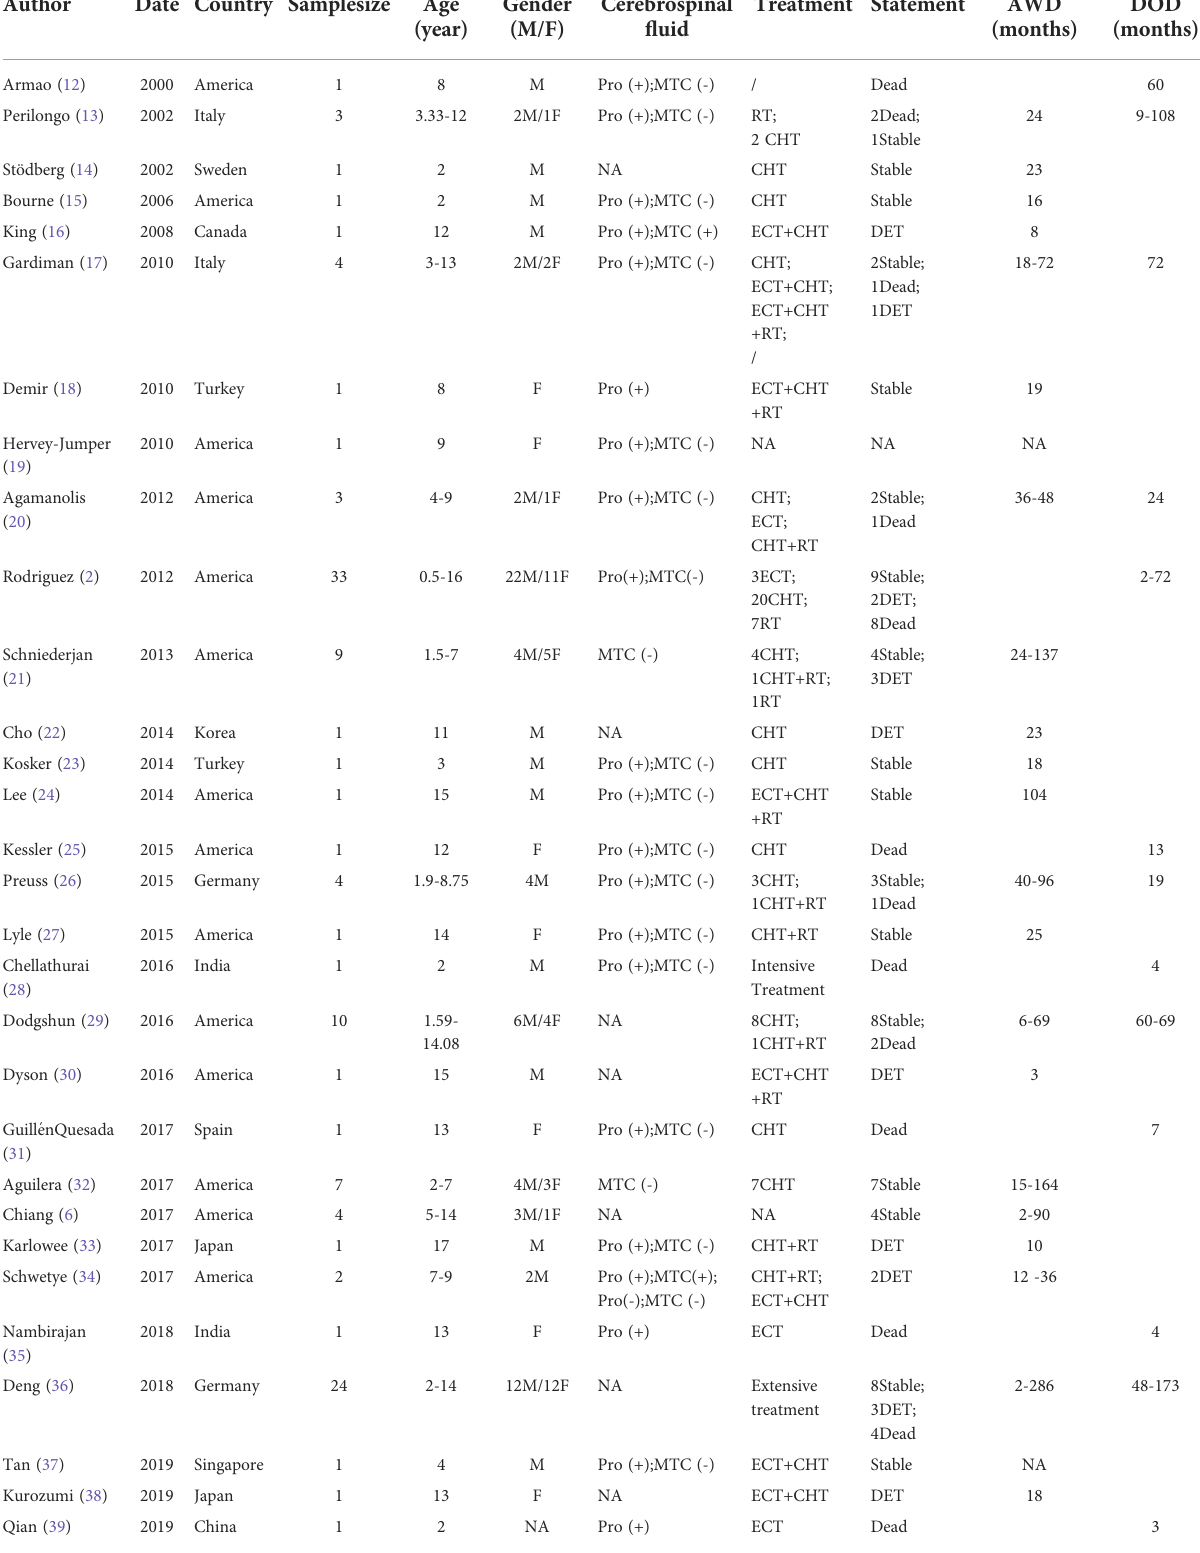
TABLE 1 Literature review of